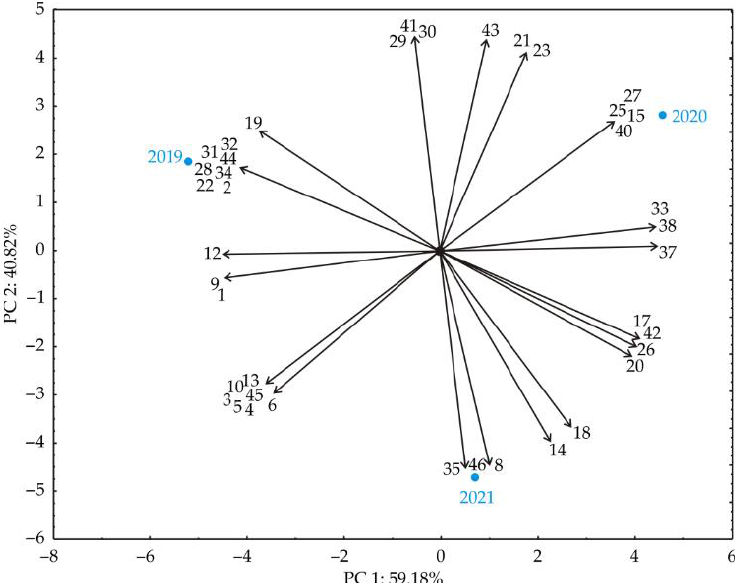
Figure 4. The PCA biplot diagram describing the relations between volatile compounds of S. officinalis hydrolate .